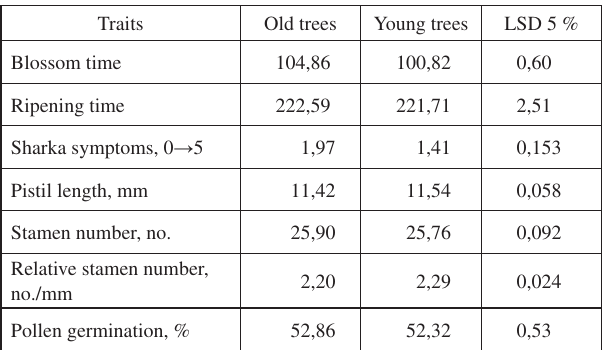
Table 4. Comparison of old and young plum trees in fi eld (Cegléd) Traits